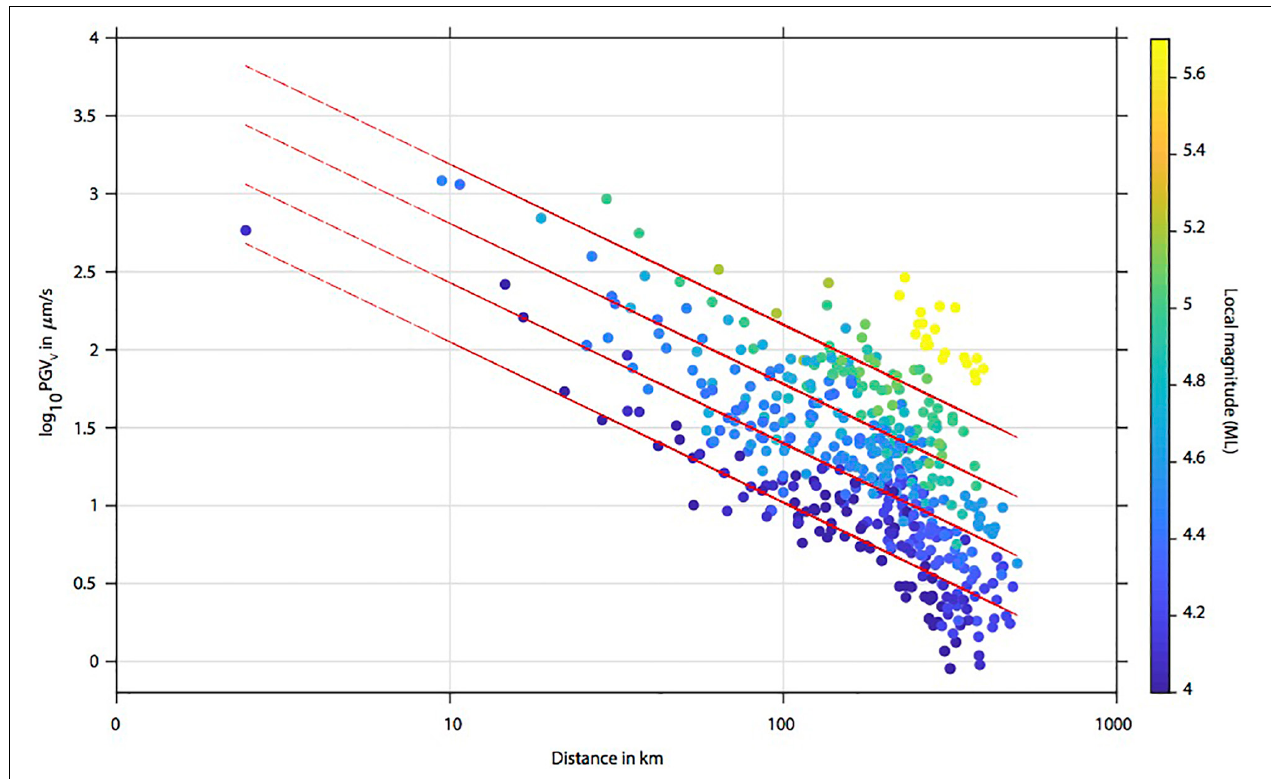
FIGURE 11 | Observed peak ground velocity (PGV V ) across the NSSN as a function of earthquake magnitude and epicentral distance. Each circle in the plot represents a single earthquake detection at a station, colored by magnitude. Six months data are considered from April 2019. Source of earthquake data is the National Seismological Center’s published catalog. Red lines represent the fitted PGV V -distance lines for M4.0, M4.4, M4.8, and M5.2 earthquakes after the regression (see text for details).